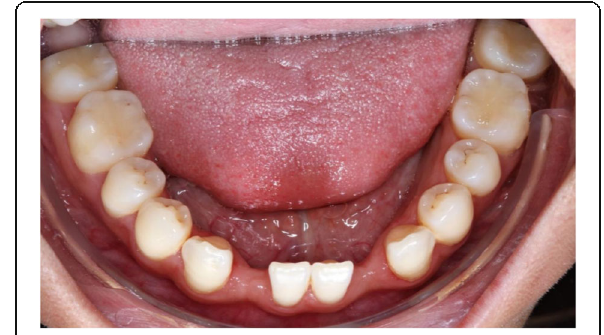
Fig. 5 Young patient with two congenitally missing lateral incisors in the mandible